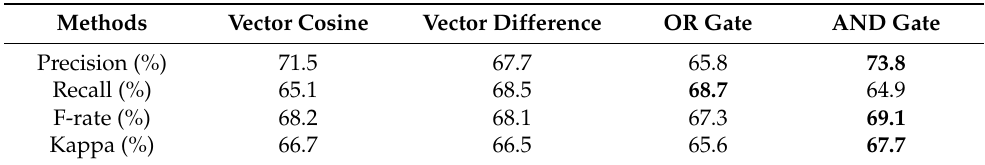
Table 5. Experimental results of the fusion